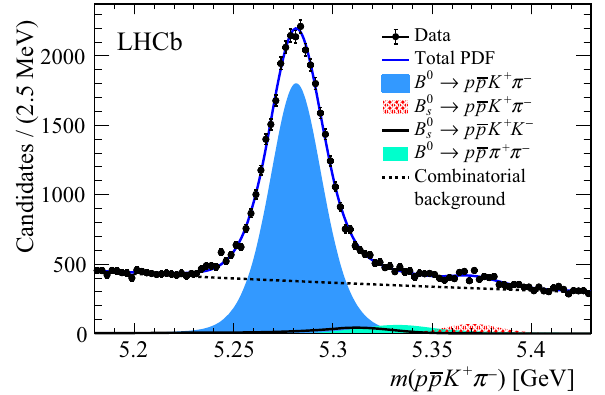
Fig. 2 Distribution of the ppK + π − invariant mass. The solid blue curve is the projection of the total fit result. The components are shown in the legend